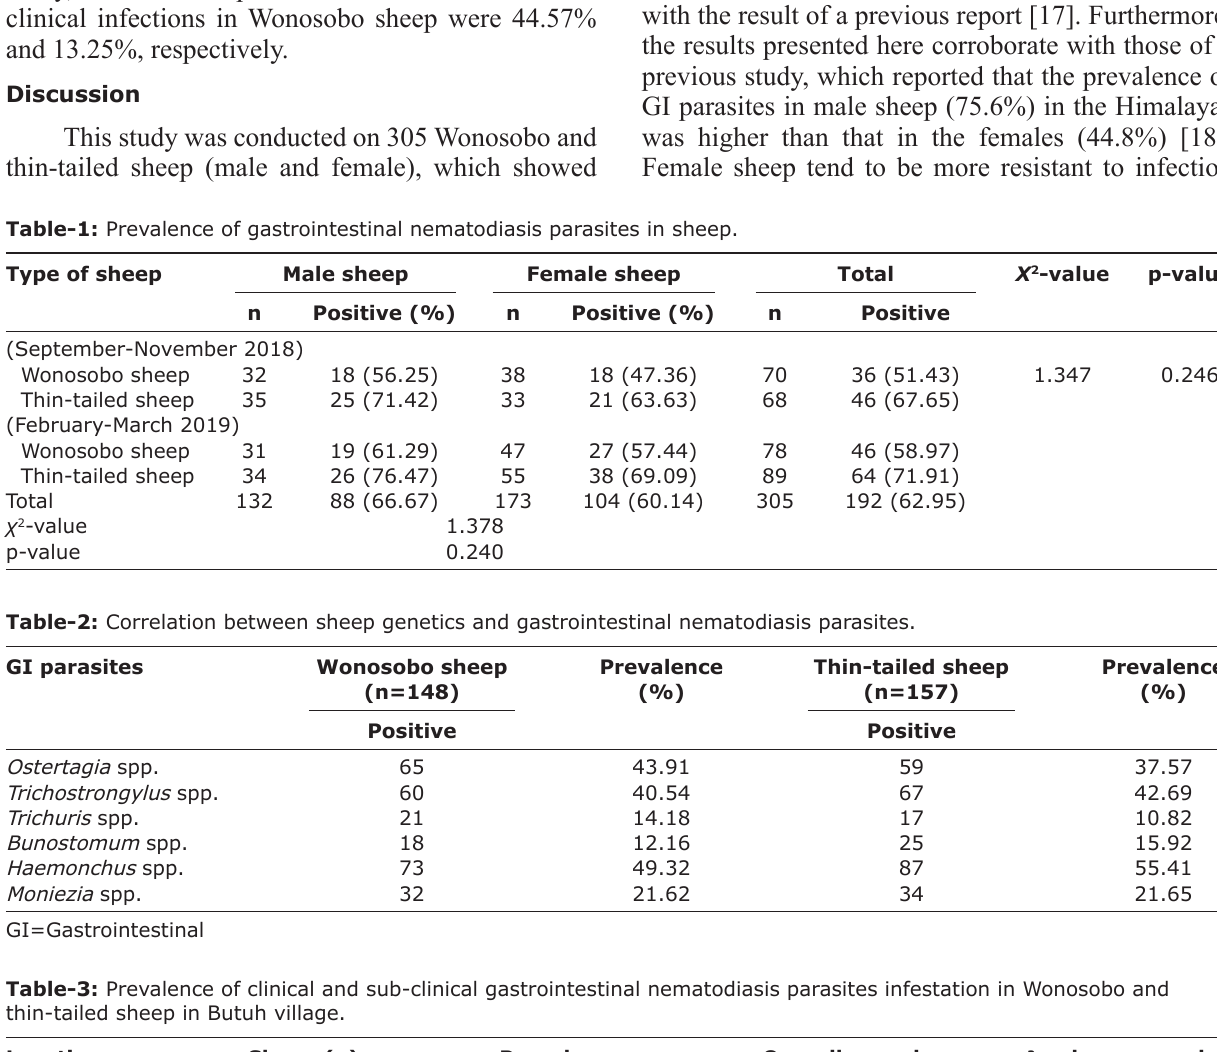
Butuh (1.586 mdpl)